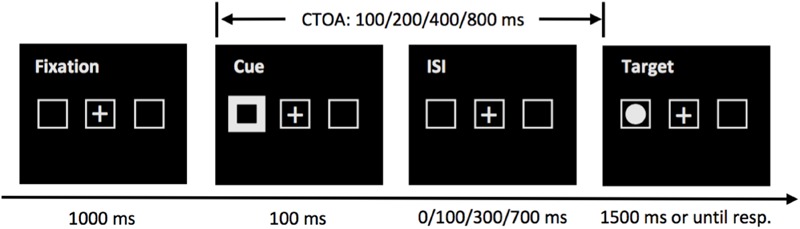
Sequence of events in a sample trial of the cueing task in Experiment 1. At the beginning of each trial, the tracking accuracy of the tracker was examined by performing a drift-check. Then, a fixation cross and three placeholders appeared on the screen, followed by a peripheral cue which was visible for 100 ms. The target was presented immediately, or 100, 300, or 700 ms later, giving four possible cue-target onset asynchronies (CTOAs): 100, 200, 400, and 800 ms. The target remained visible for a maximum of 1500 ms or until a speeded response was issued. For illustration purpose only, the stimuli are not drawn to scale.